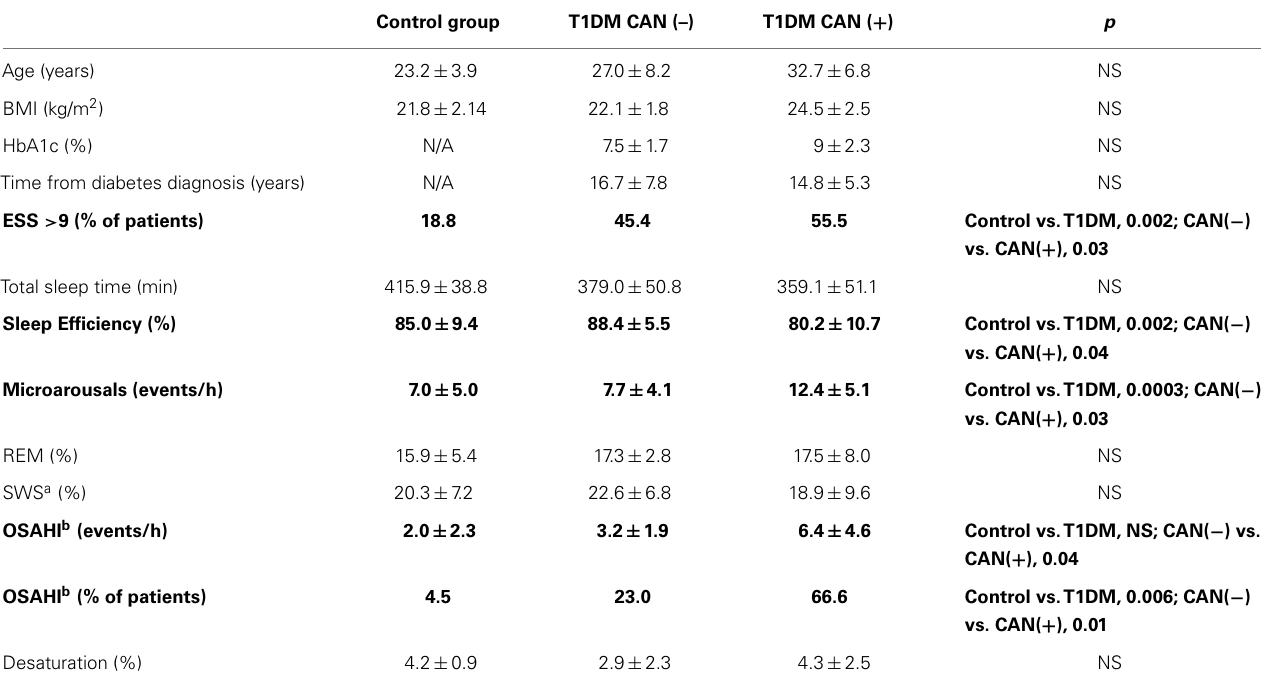
Table 1 | Clinical, metabolic characteristics, and polysomnography parameters in controls andT1DM patients with (CAN + ) and without (CAN − ) cardiovascular autonomic neuropathy